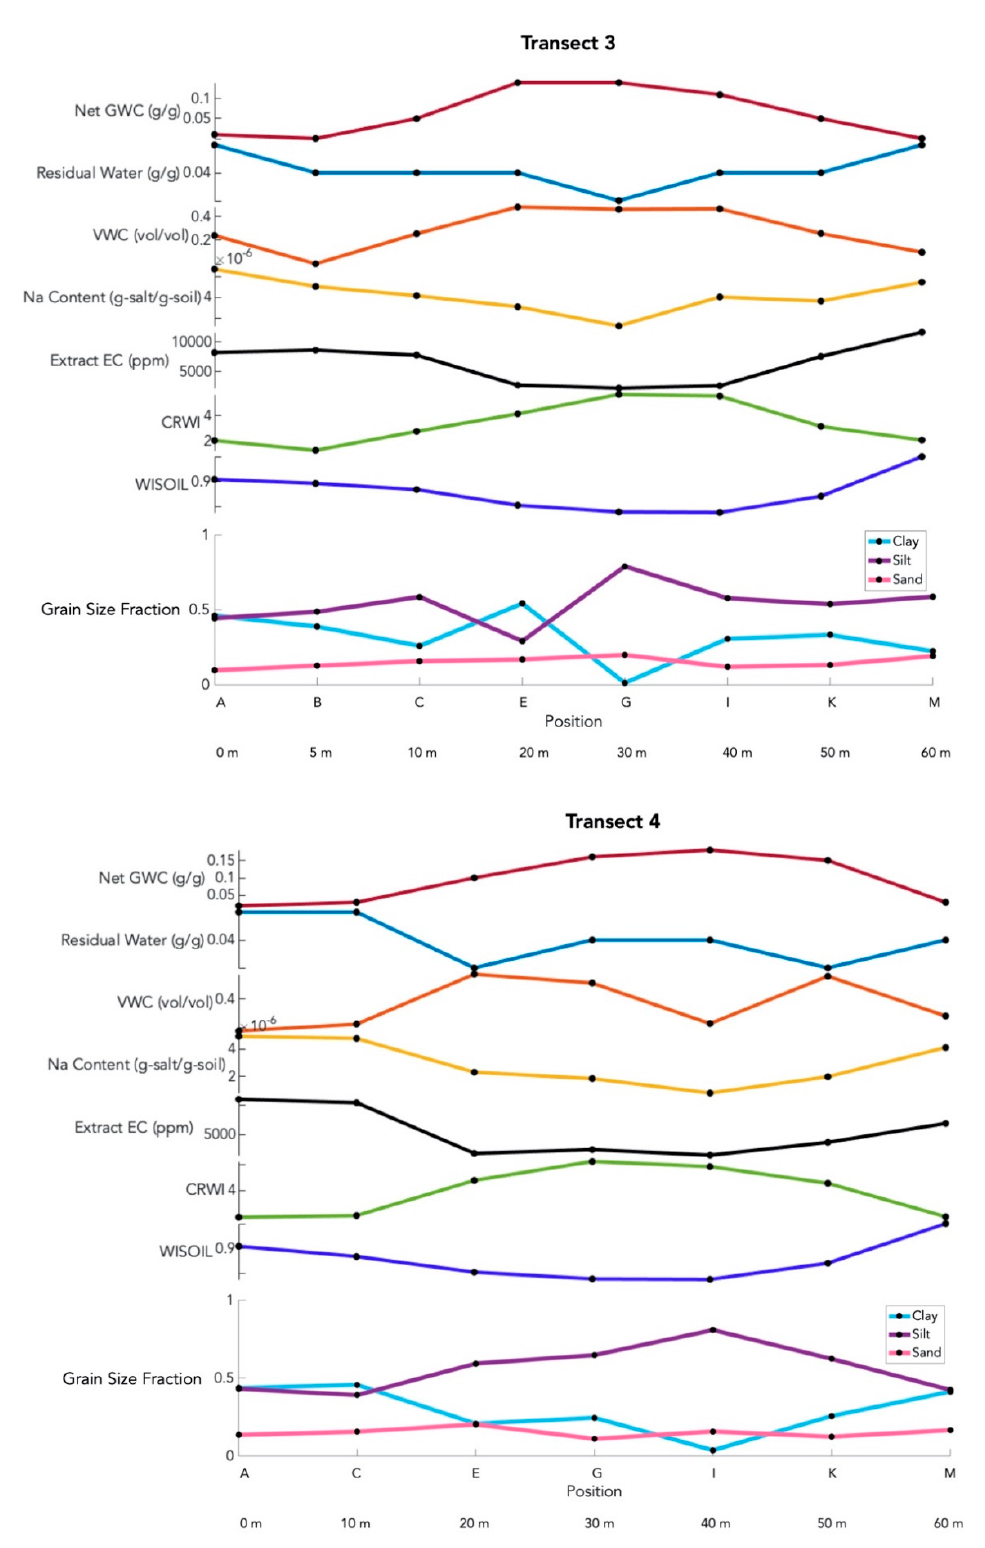
Figure 4. Ground truth data summary for the two sampling transects crossing the AHS plume from dry soil north of the plume, through the plume thalweg, to the south margin. Net GWC is net gravimetric water content (soil water mass per gram of soil), VWC is volumetric water content (cm 3 of water per cm 3 of soil) measured via 5TE probe. Extract EC is soil electrical conductivity converted to ppm (parts per million) solutes. CRWI and WISOIL are two reflectance spectroscopic soil moisture indices (see text).